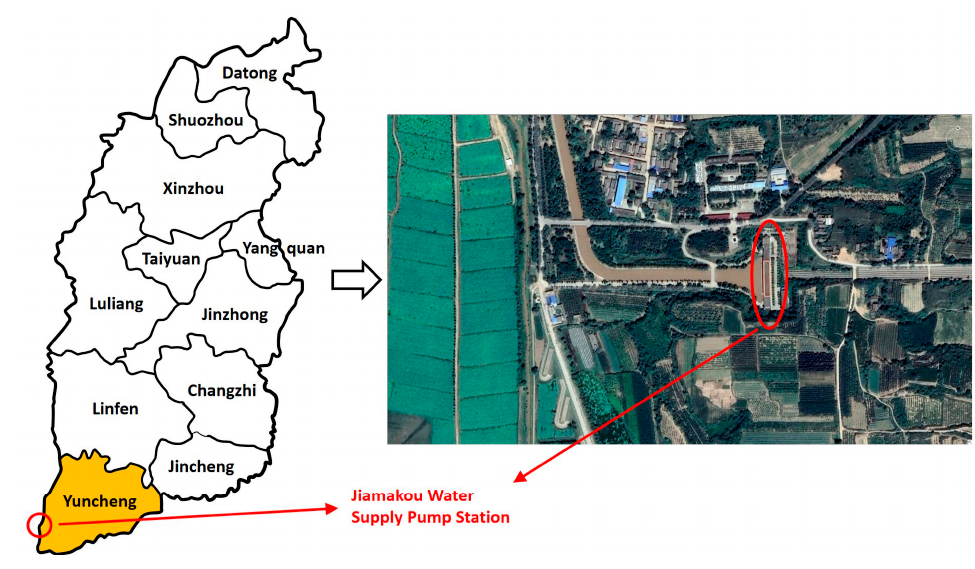
Figure 1. Location of Jiamakou water supply pumping station. Table 1. Double-suction 800S-76 model centrifugal pump working parameters.